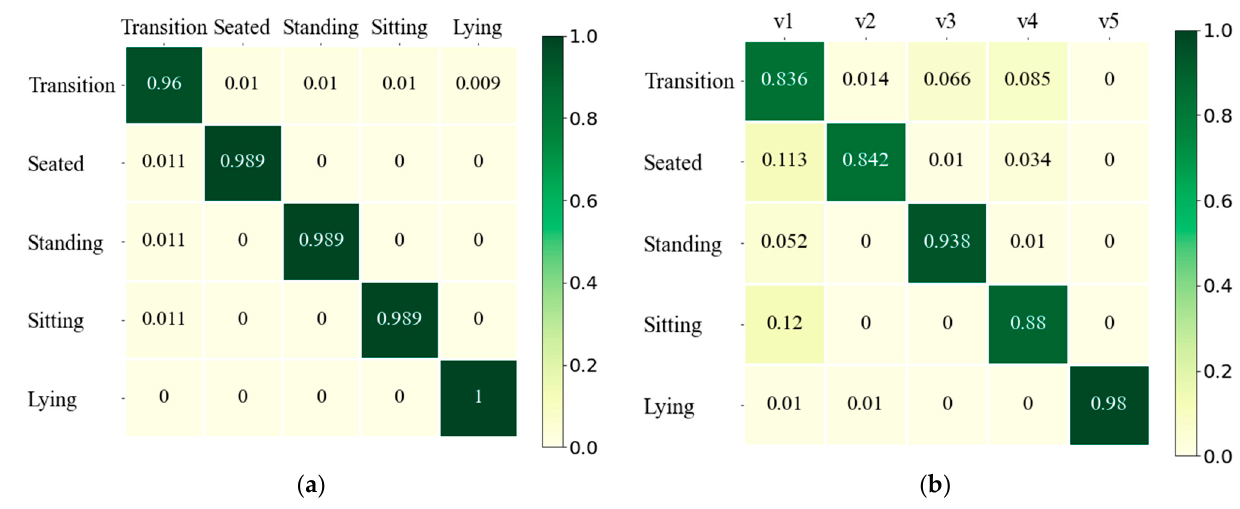
Figure 10. Heatmap visualization after training with Baum-Welch Algorithm for: ( a ) HMM transition probability matrix A ; ( b ) HMM emission probability matrix B .